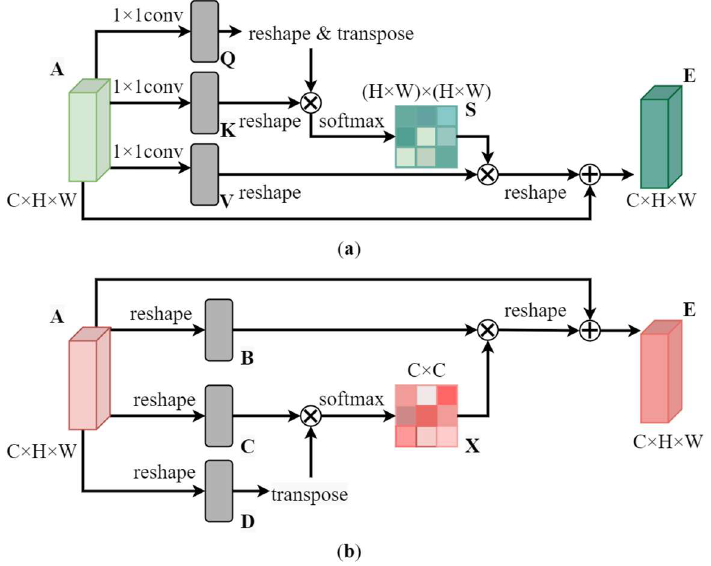
Figure 6. The details of spatial self-attention and channel self-attention. ( a ) Spatial self-attention module; ( b ) Channel self-attention module.